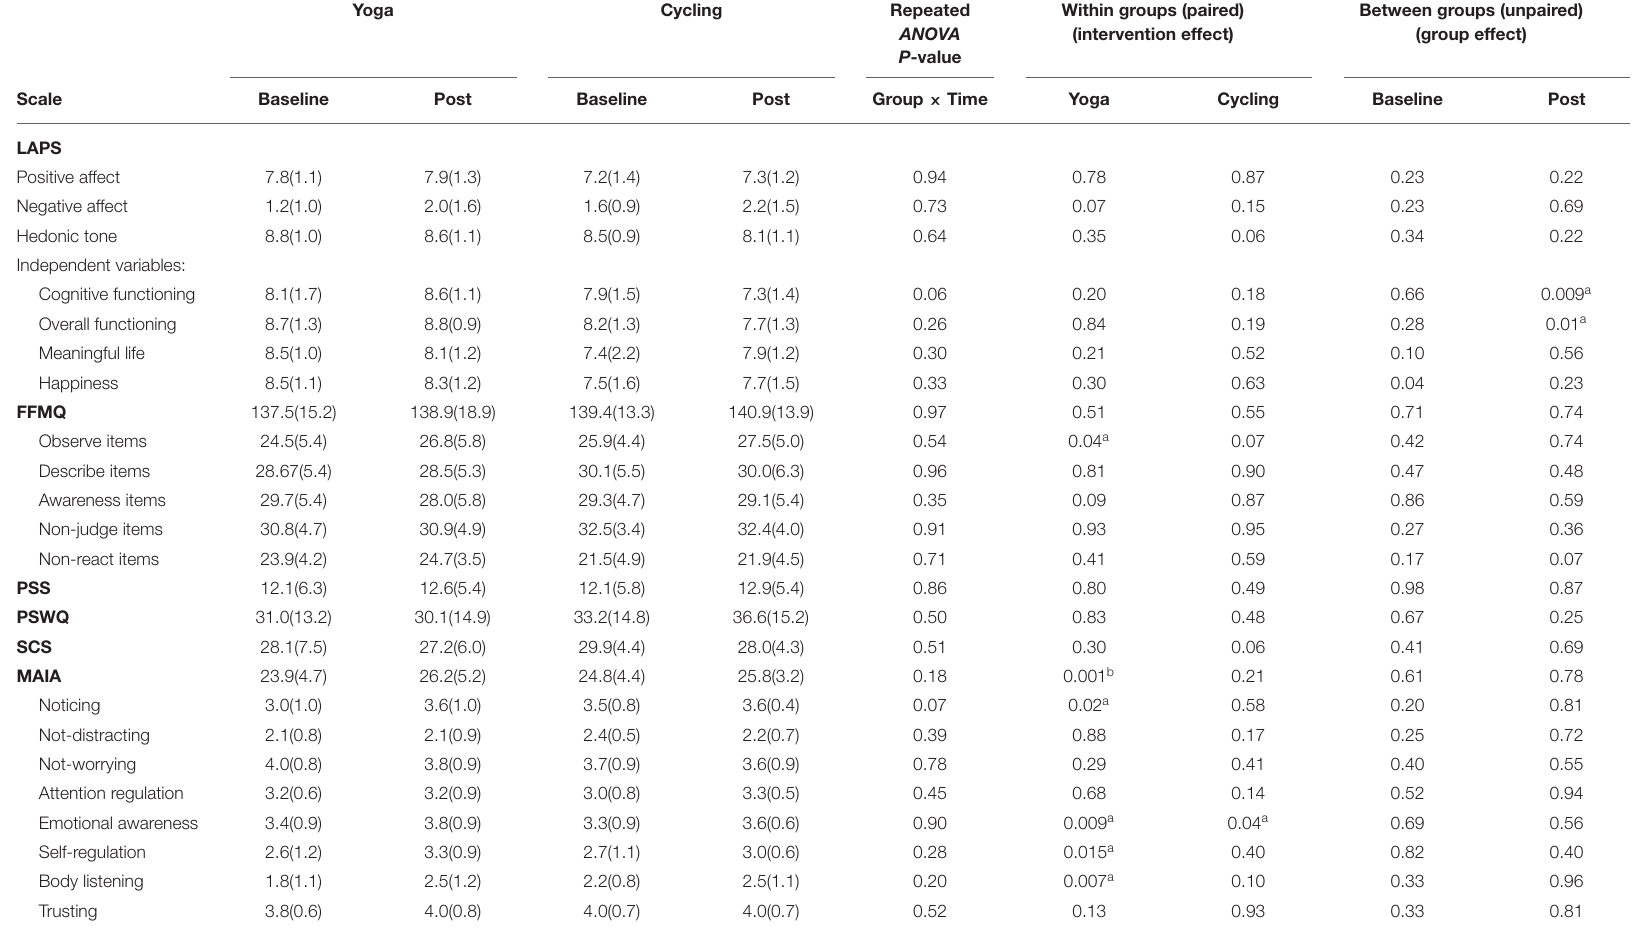
Yoga Cycling Repeated